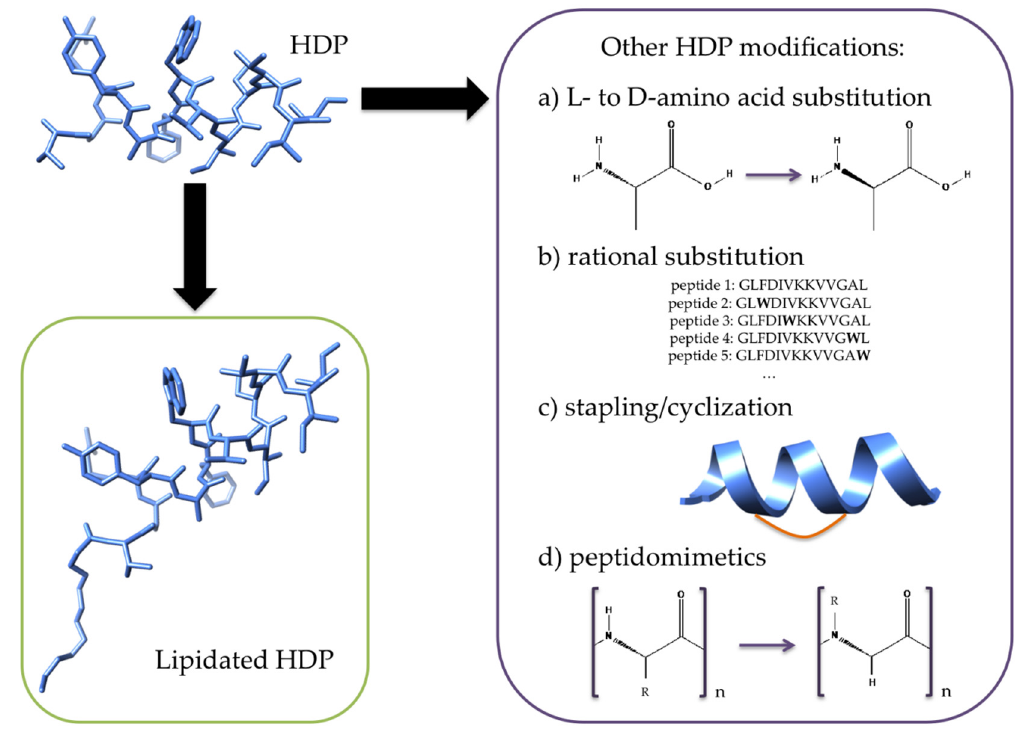
Figure 2. Comparison of lipidated HDPs (green box) to alternative approaches (purple box): replacement of one or more L -amino acids for D -amino acids in the HDP, rational substitution of amino acids, stapling or cyclization, and, finally, the use of peptidomimetics, where, e.g., the side chain (designated as R) is not on the C α but rather on the N atom.